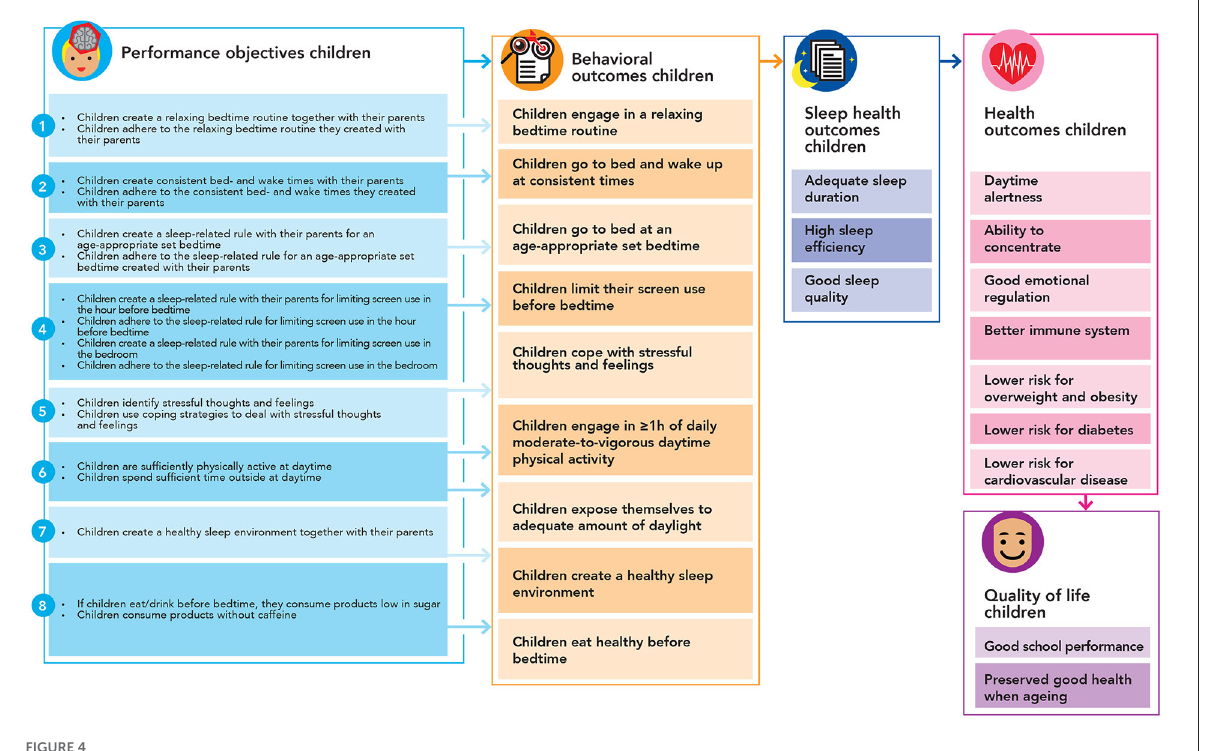
FIGURE4 Logic model of change for